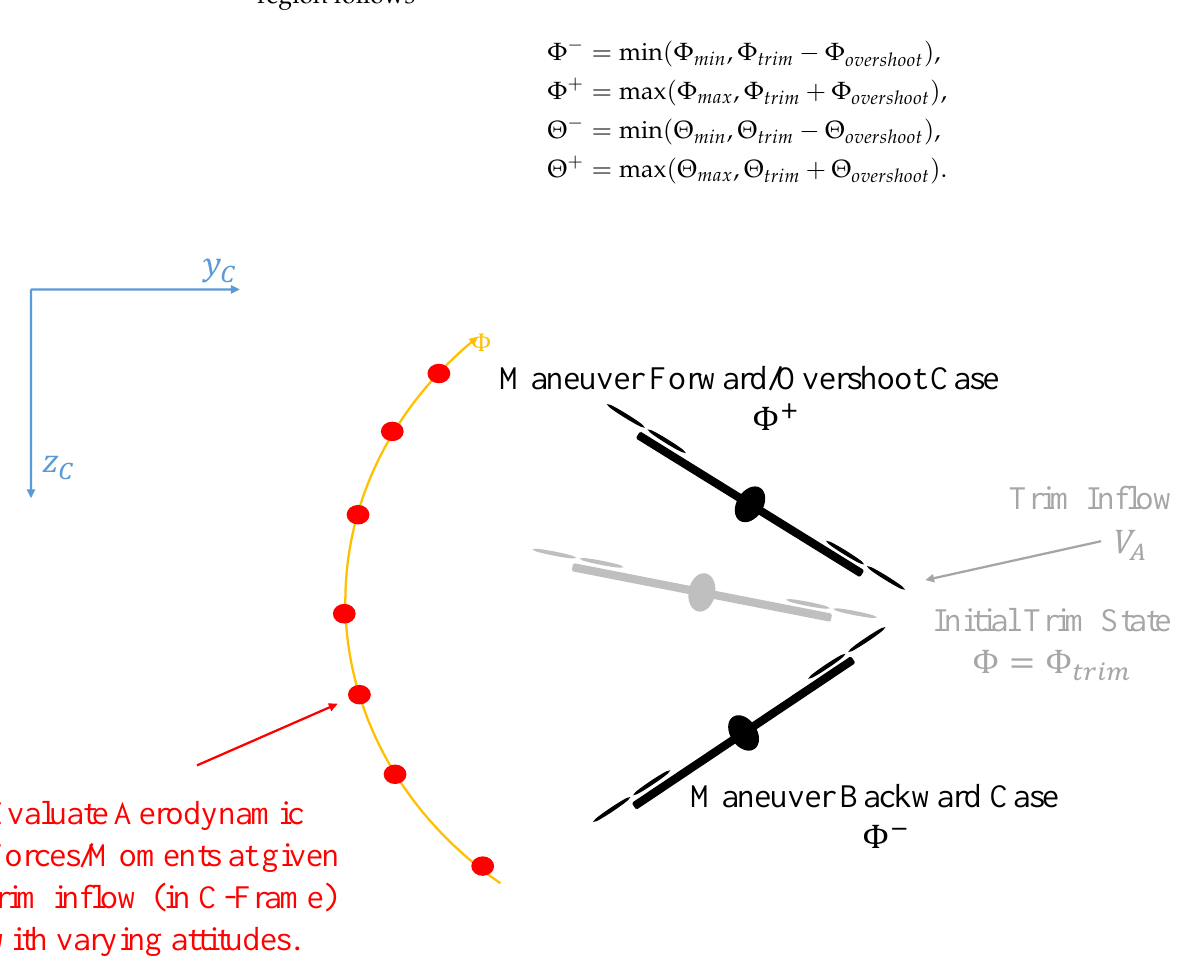
Figure 4. Illustration of attitude deviation for calculating disturbance moments and forces during maneuvers (2D example for visualization